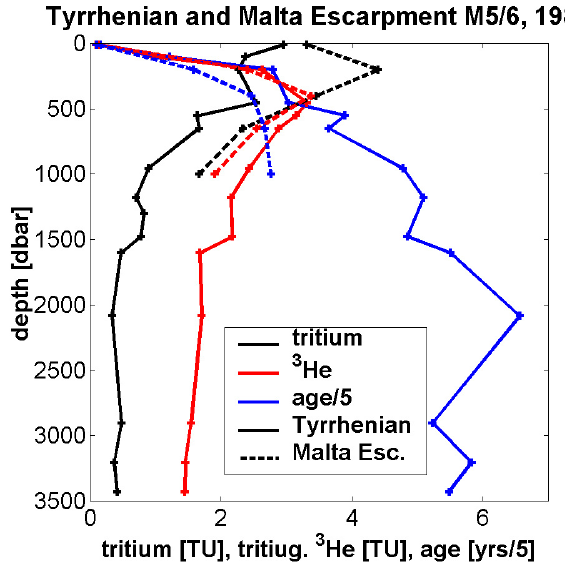
Fig. 6. Profiles of tritium, tritiugenic 3 He [TU] and tritium- 3 He- ages [years/5], Meteor 5/6, 1987, in the Tyrrhenian Sea (Sta. 786) and at the Malta Escarpment upstream of the Sicily Strait (Sta. 779). For Sta. 779 only the upper 1000m are shown, for station positions see Fig.